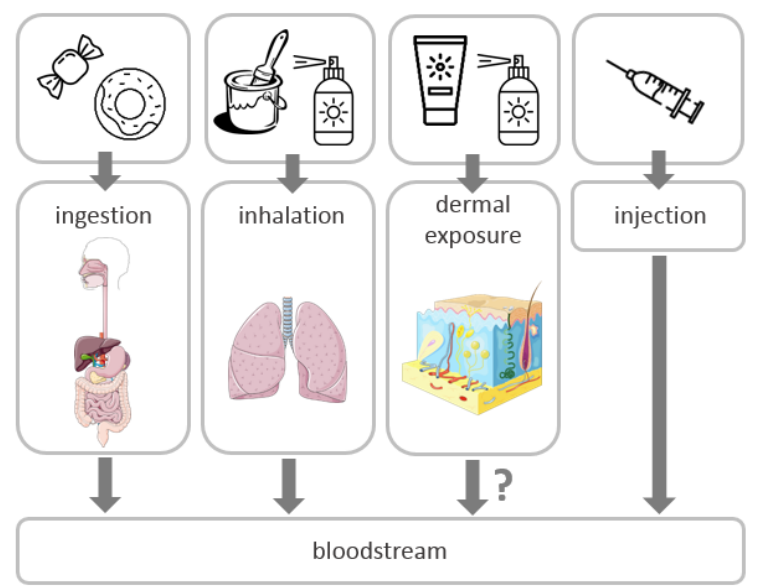
Figure 4. Routes of exposure and distribution of TiO 2 NPs in the human body.